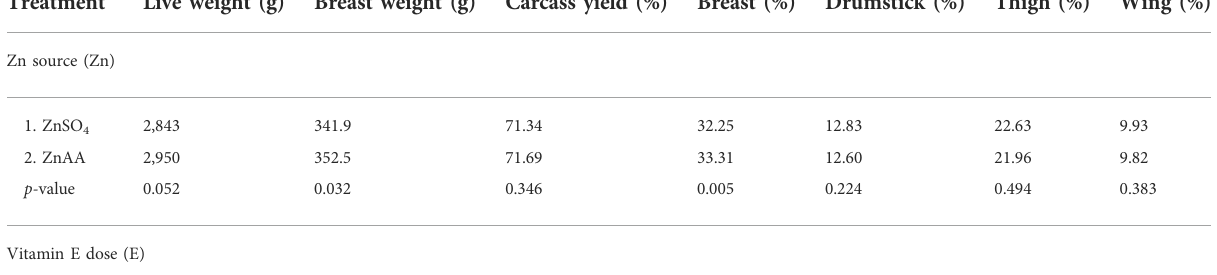
TABLE 3 Effect of the supplemental zinc (Zn) source and vitamin E level (Vit E) on live weight and carcass composition of broilers at slaughter age (day 37). Treatment